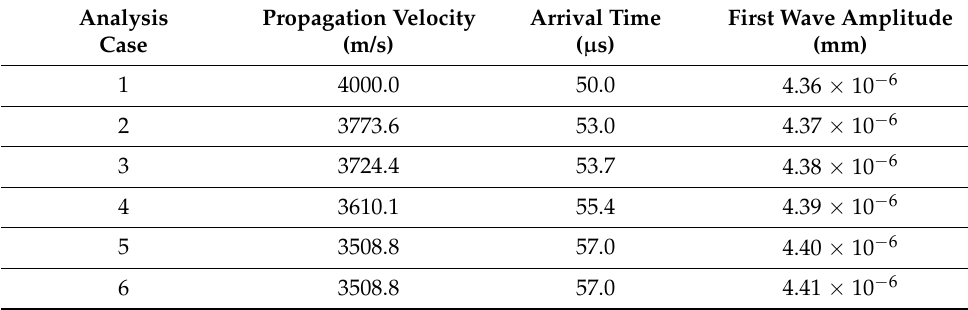
Table 3. Simulation